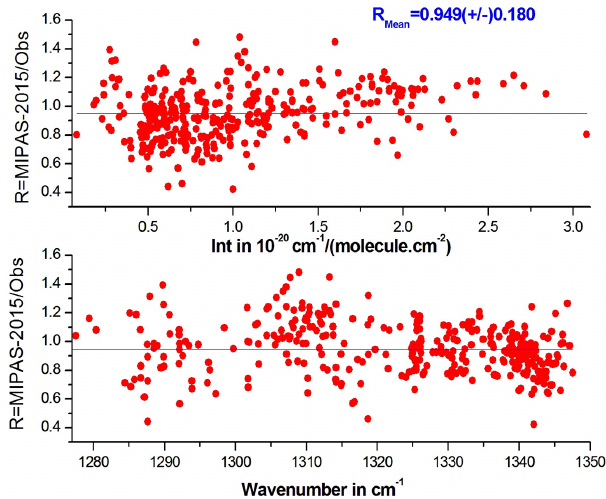
Figure 6. Comparison between the line intensities measured in this work using a Fourier transform spectrum (Obs, 299.7K, 0.03hPa, absorption path length = 302cm, Perrin et al., 2004; Perrin, 2013) and those available in MIPAS-2015. The comparison, performed as a function of the intensities and wavenumbers (upper and lower panels, respectively), accounts for the temperature correction from 299.7 to